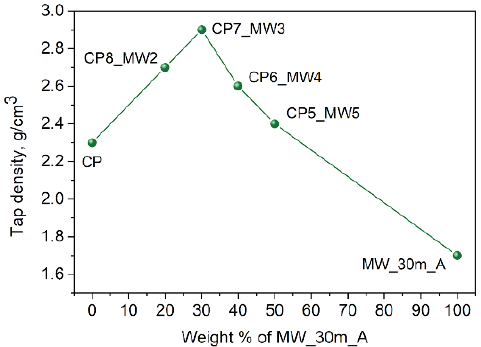
Figure 11. The tap density of NMC811 obtained by mixing the CP_A and MW_30m_A samples at various mass ratios (the line is a guide to the eye).